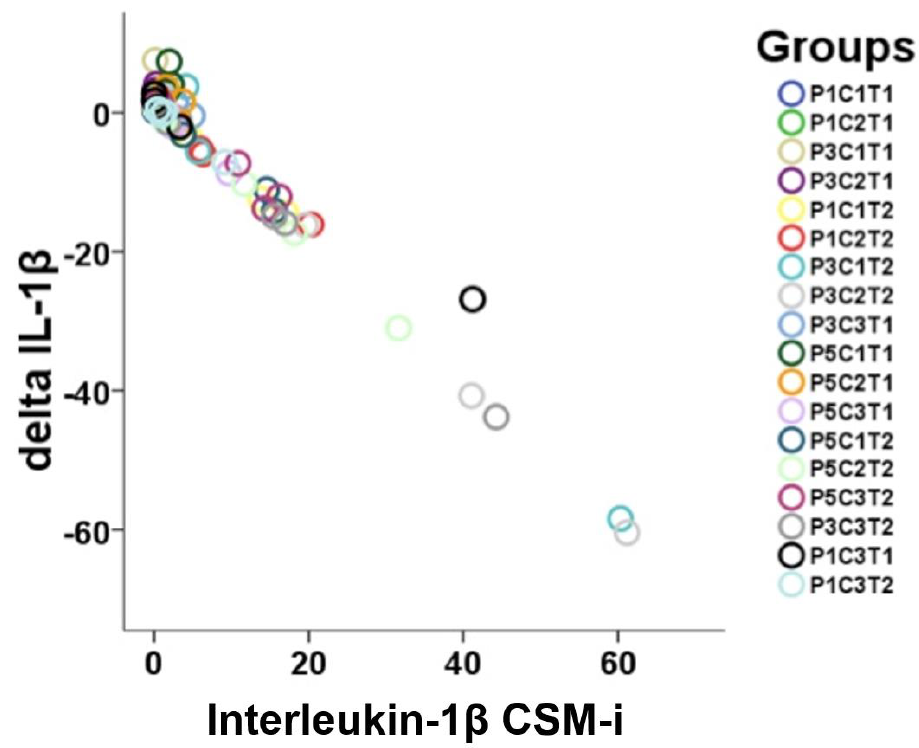
Figure 4. Visualization of linearity between CSM-i and the mathematical difference of CSM-e minus CSM-i ( ∆ target) of all the P, C, and T assemblies possible ( n = 18) for IL-1 β . The opposite was true for the expression of TNF-α (Figure 5). Only the combinations P1C2T1, P3C1T1 and P3C2T1 produced lower expression of TNF-α in CSM-e compared to CSM-i.